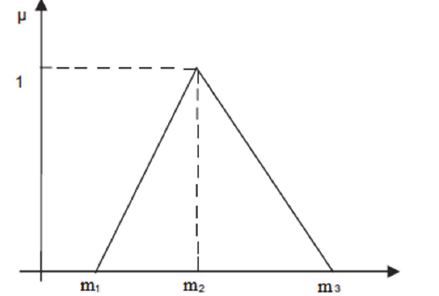
Fig. 2. Triangular membership function